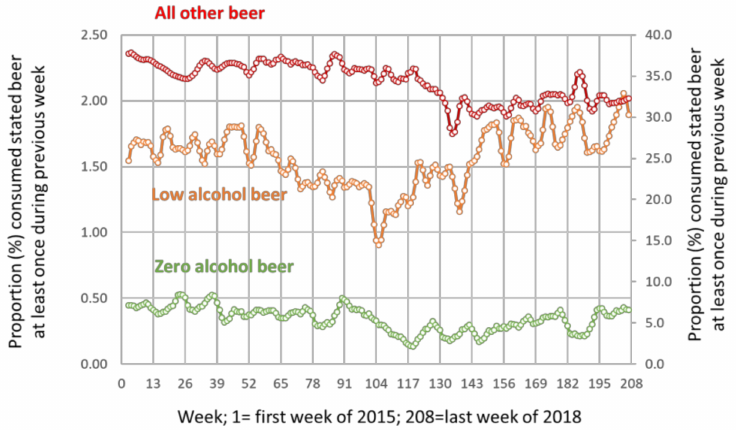
Figure 3. Proportion (%) of survey respondents who reported consuming at least one drink of zero alcohol beer (green, left vertical axis), low alcohol beer (orange, left vertical axis) and all other beer (red, right vertical axis) by week, 2015 to